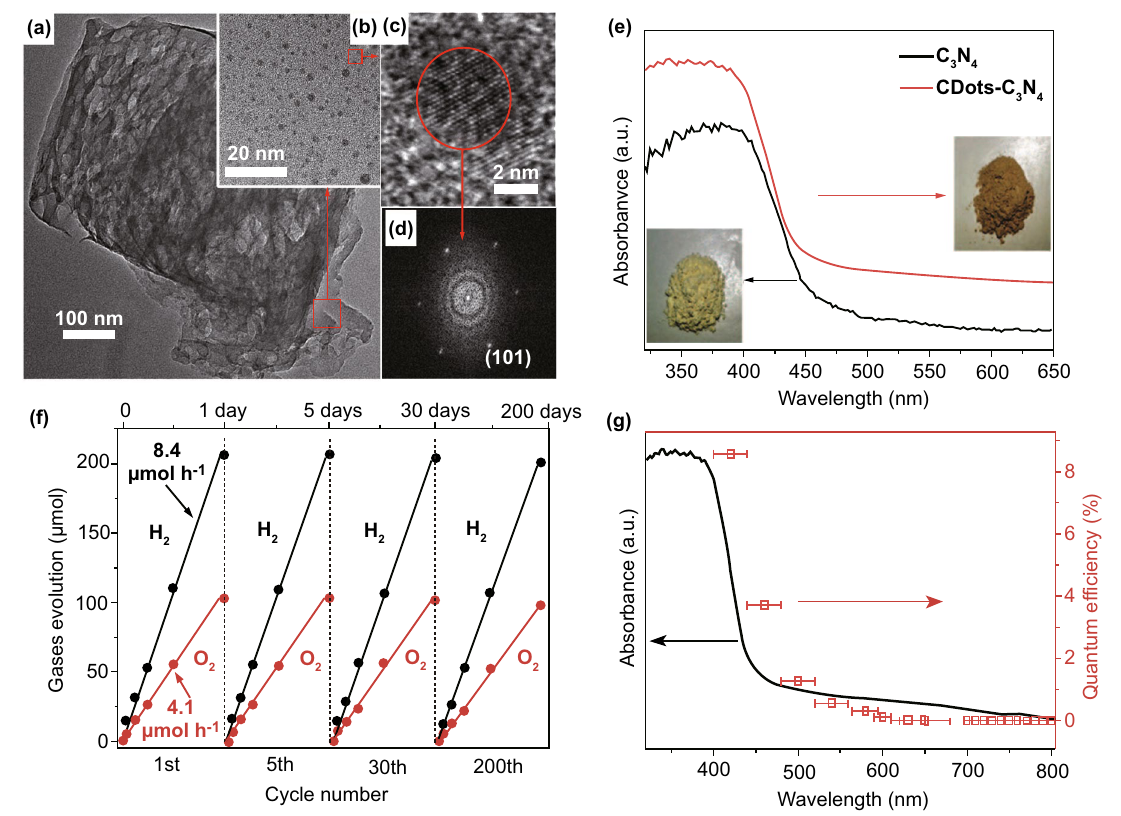
Fig. 15 a – d TEM of C‑QDs/C 3 N 4 . e UV–Vis absorption spectrum of C 3 N 4 and C‑QDs/C 3 N 4 photo‑catalysts. f Time period of O 2 and H 2 pro‑ duction from H 2 O after vis‑light irradiation catalyzed via C‑QDs/C 3 N 4 . g Wavelength‑based QE (red dots) of H 2 O splitting via C‑QDs/C 3 N 4 . Adapted with permission from Ref.